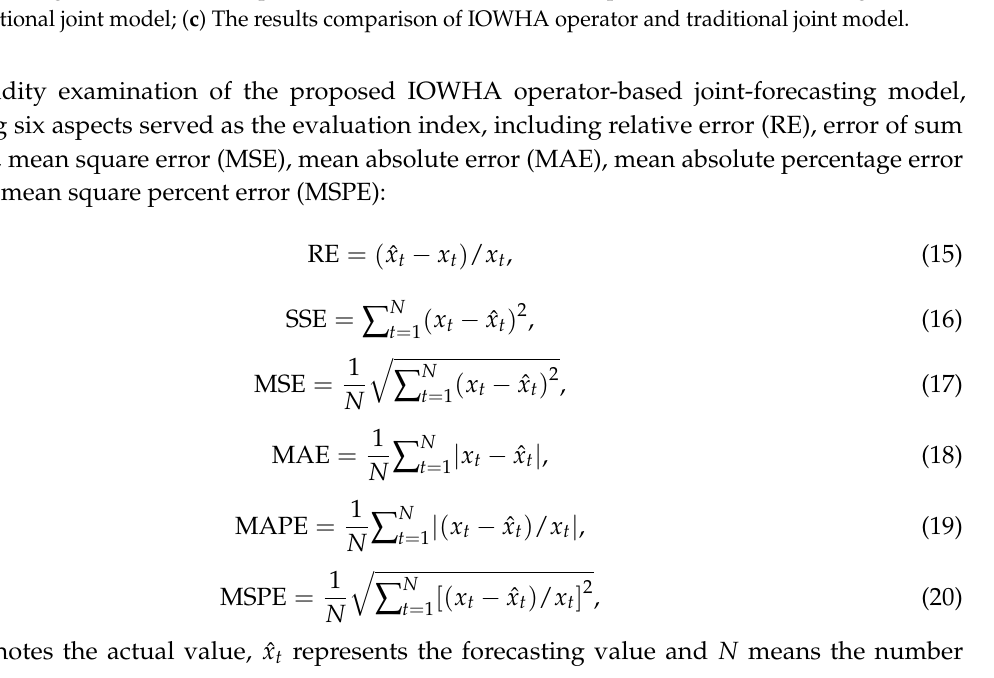
Figure 4. Single and joint-forecasting results of electricity demand. ( a ) The results comparison of MGM(1,1), Logistic and IOWHA operator model; ( b ) The results comparison of MGM(1,1), Logistic and traditional joint model; ( c ) The results comparison of IOWHA operator and traditional joint model.